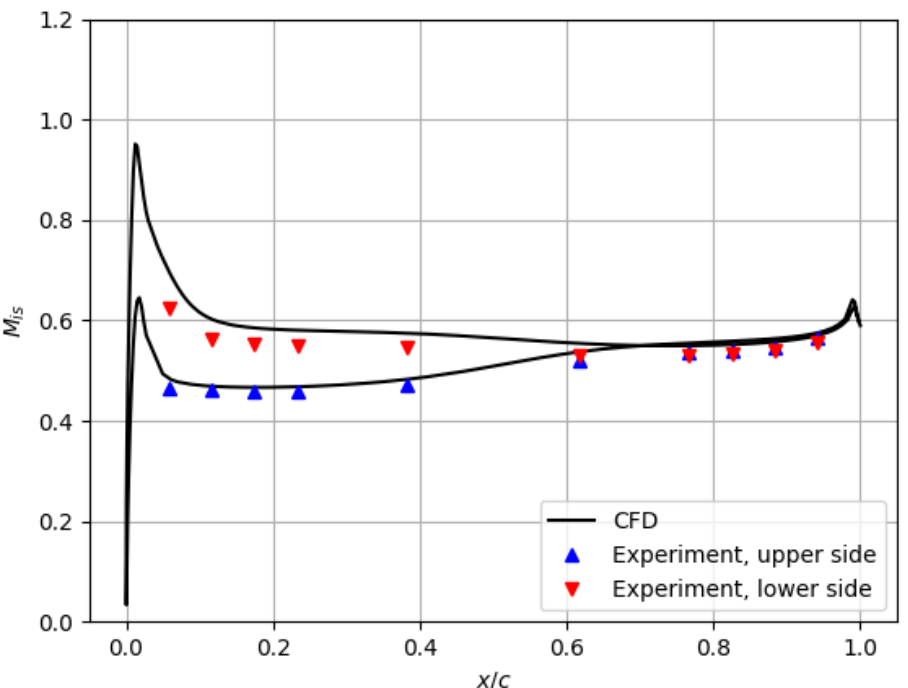
Figure 17. Isentropic Mach number distribution along the middle blade (blade no. 3) for α = 0°.